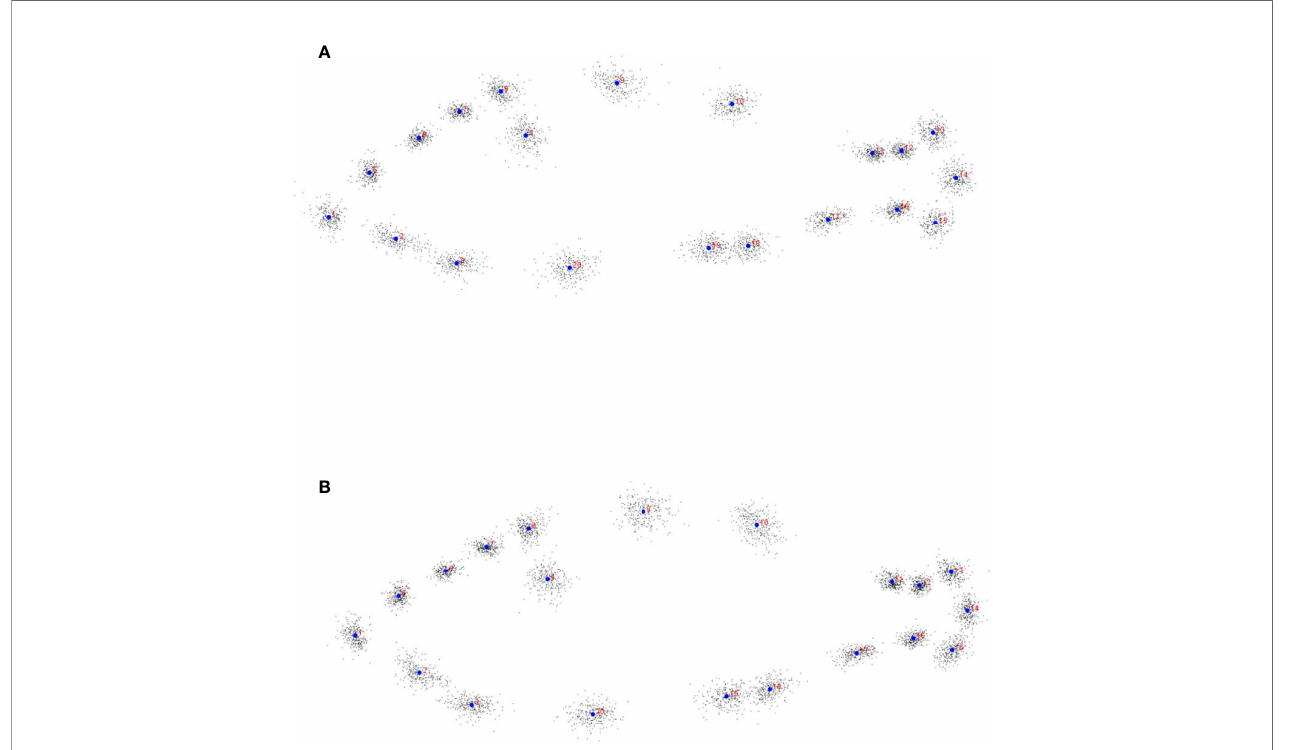
FIGURE 2 | Superimposition of vectorized landmarks for all samples of (A) wild ( n = 244), and (B) hatchery-reared ( n = 276) marbled rock fi